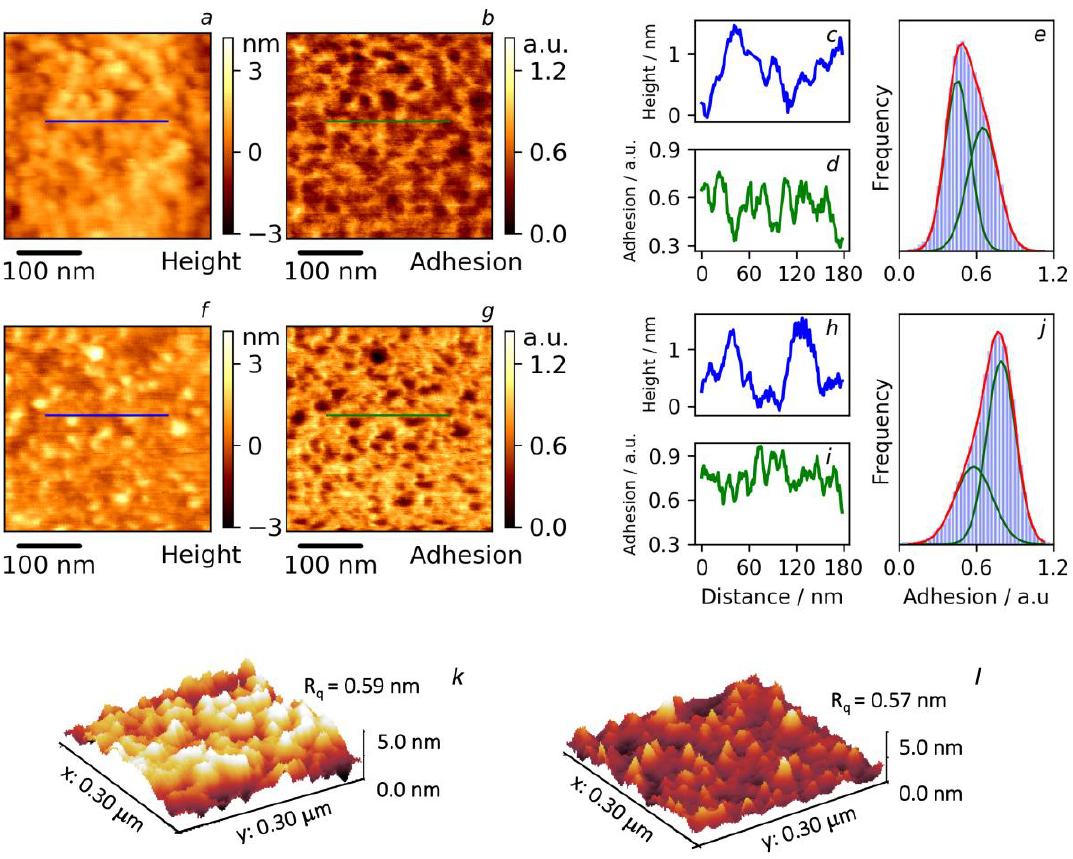
Figure 6. AFM results for PUI-530 ( a – e , k ) and PUI-2000 ( f – j , l ): surface topography ( a , f ), adhesion maps ( b , g ), topography profiles ( c , h ), adhesion profiles ( d , i) , distributions of adhesion values ( e , j ) and 3D images (k, l ).